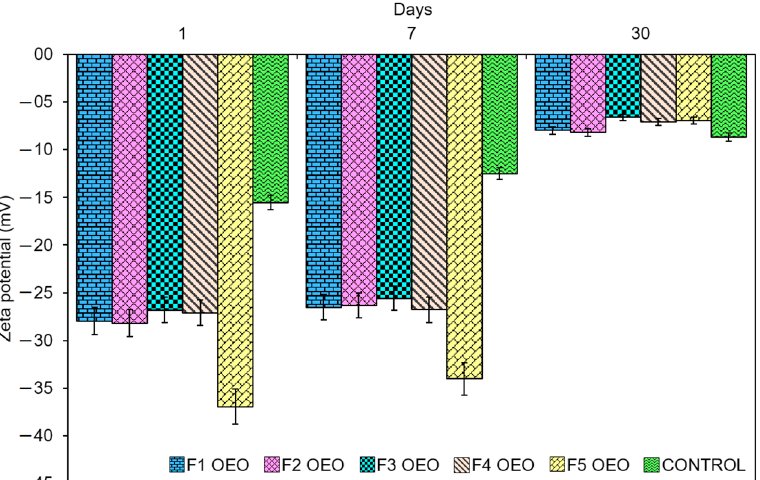
Figure 2. Zeta potential values of OEO nanoliposomes and control sample after 1 day, 1 week, and 1 month of preparation.